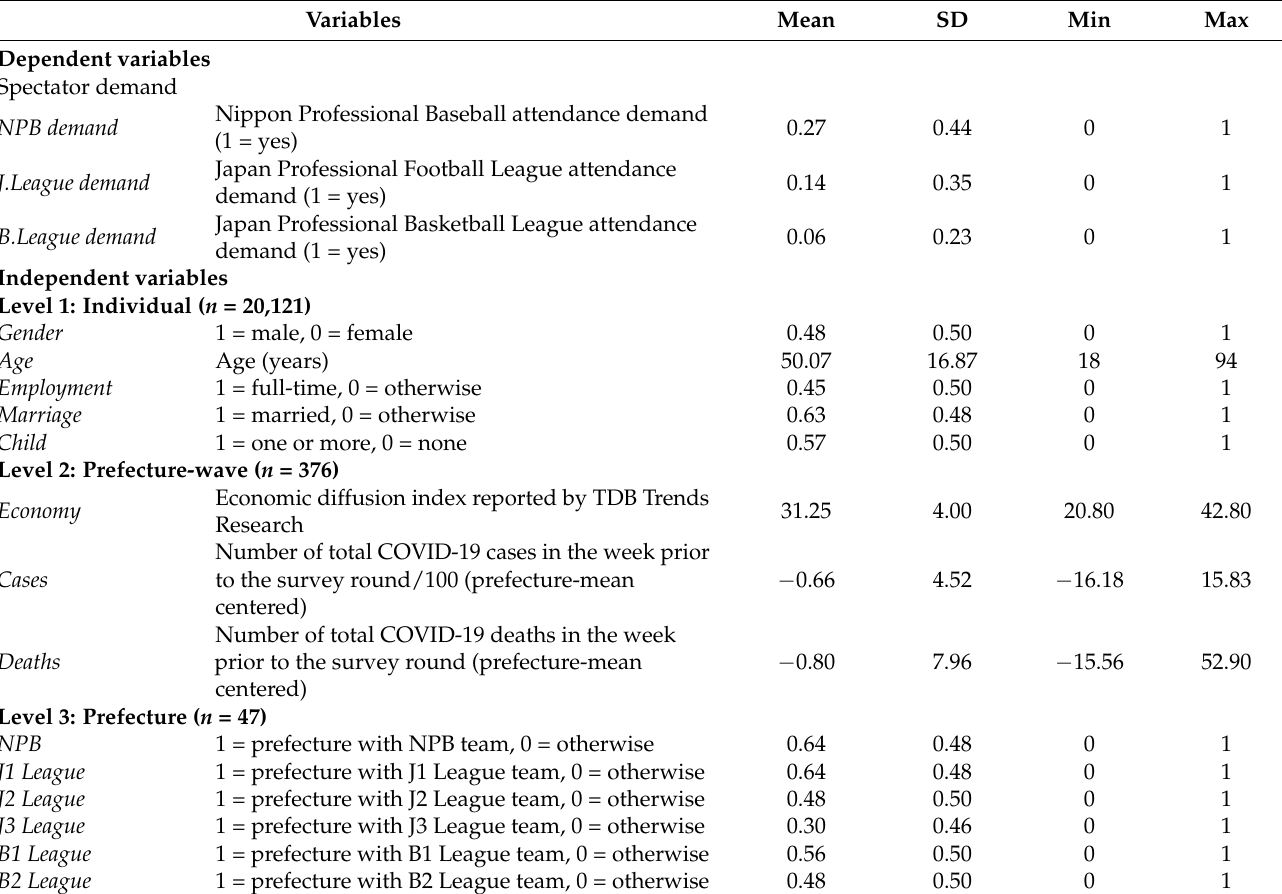
Table 1. Definitions and descriptive statistics of variables used in the